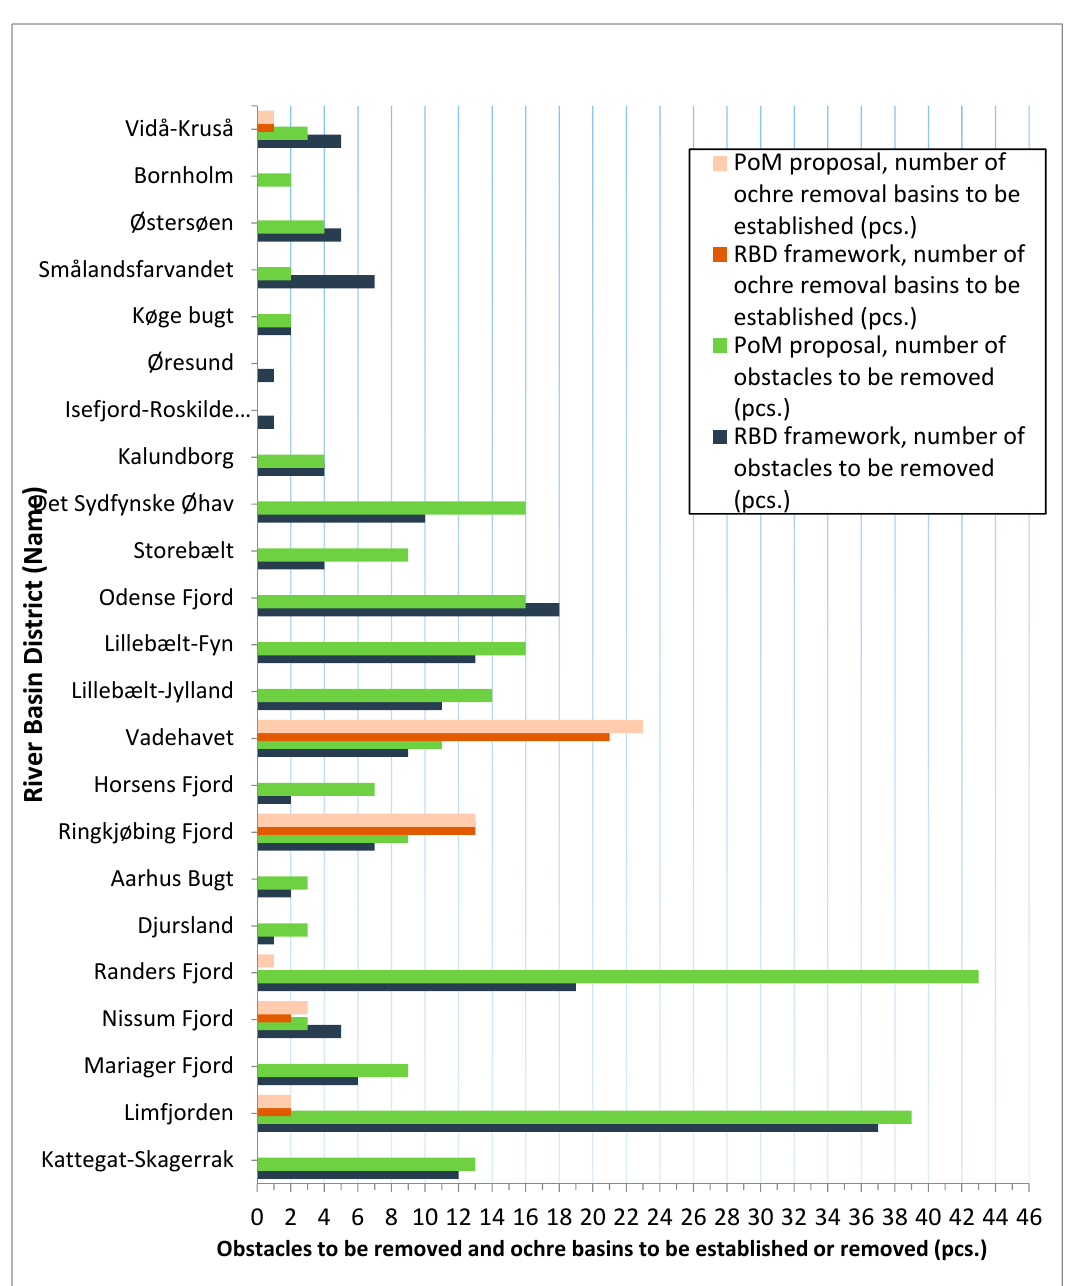
Figure A1. RBD framework requirements relative to water council proposals in the RBMPs 2015–2021 (number of obstacles to be removed and number of ochre-removal basins to be established (pcs.)). The RBD framework compared with the suggested measures from the water council process. The PoM proposal is almost similar to the suggestions made by the water councils.